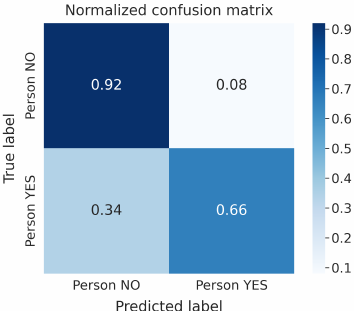
Figure 10. Normalized Confusion Matrix K-Means with t-SNE model—all attributes, static